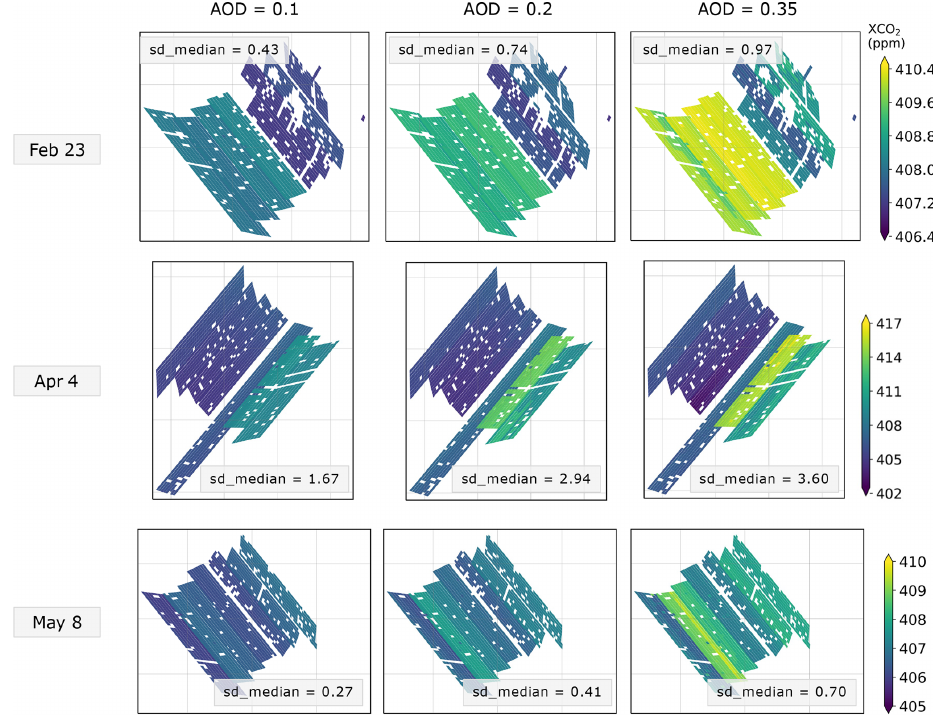
Figure 15. Retrieved X CO using a simulated dust type aerosol near 800hPa and two different optical depths for all three simulated SAMs. 2